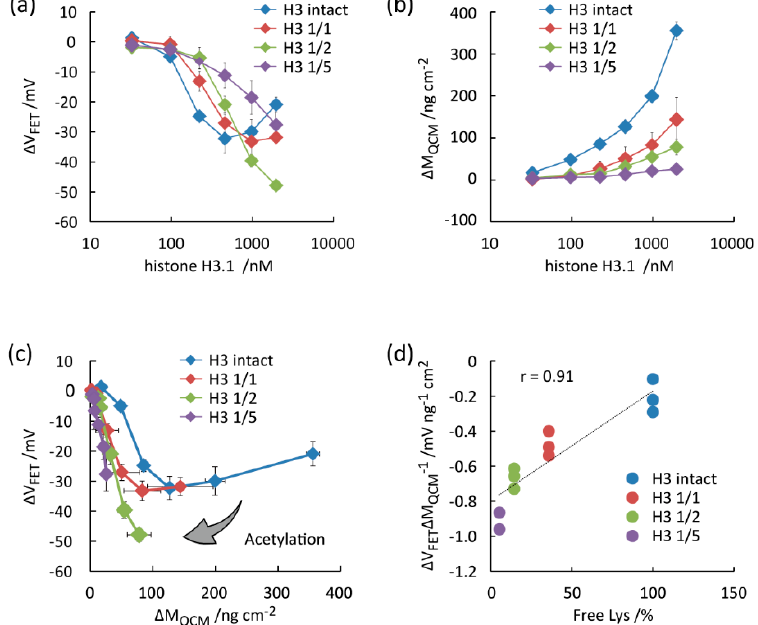
Figure 4. Evaluation of the degree of Lys acetylation in histone H3 treated with sulfo-NHS-acetate through parallel measurements of FET and QCM using the gold electrode functionalized by anti-histone H3 aptamer and SB SAM. ( a ) Δ V FET vs. histone H3.1 concentration. ( b ) Δ M QCM vs. histone H3.1 concentration. ( c ) Δ V FET vs. Δ M QCM . ( d ) Δ V FET / Δ M QCM vs. free Lys contents in histone H3.1.